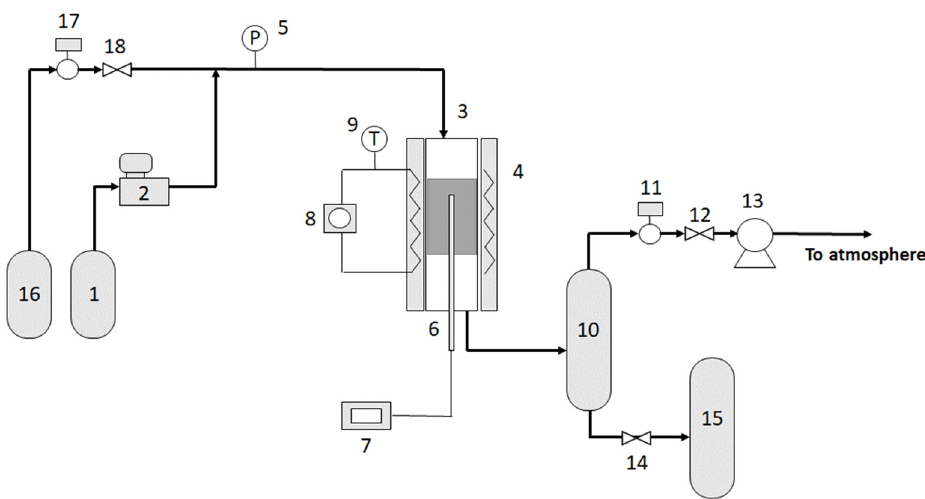
Figure 3. Scheme of a pilot plant, containing 0.5 L of catalyst, used by Semenov et al. to verify catalyst stability in runs prolonged for 1250 h. (1) Raw material container; (2) Dosing pump; (3) Tubular fixed bed reactor; (4) Heating furnace; (5) Pressure gauge; (6) Movable thermocouple; (7) Temperature reading; (8) and (9) Temperature regulation system; (10) Ethyl acetate, ethanol condenser; (11)–(13) Hydrogen flow measurement; (15) Container to collect liquid produced; (16) Hydrogen bottle; (17) Pressure reducer; (18) valve.